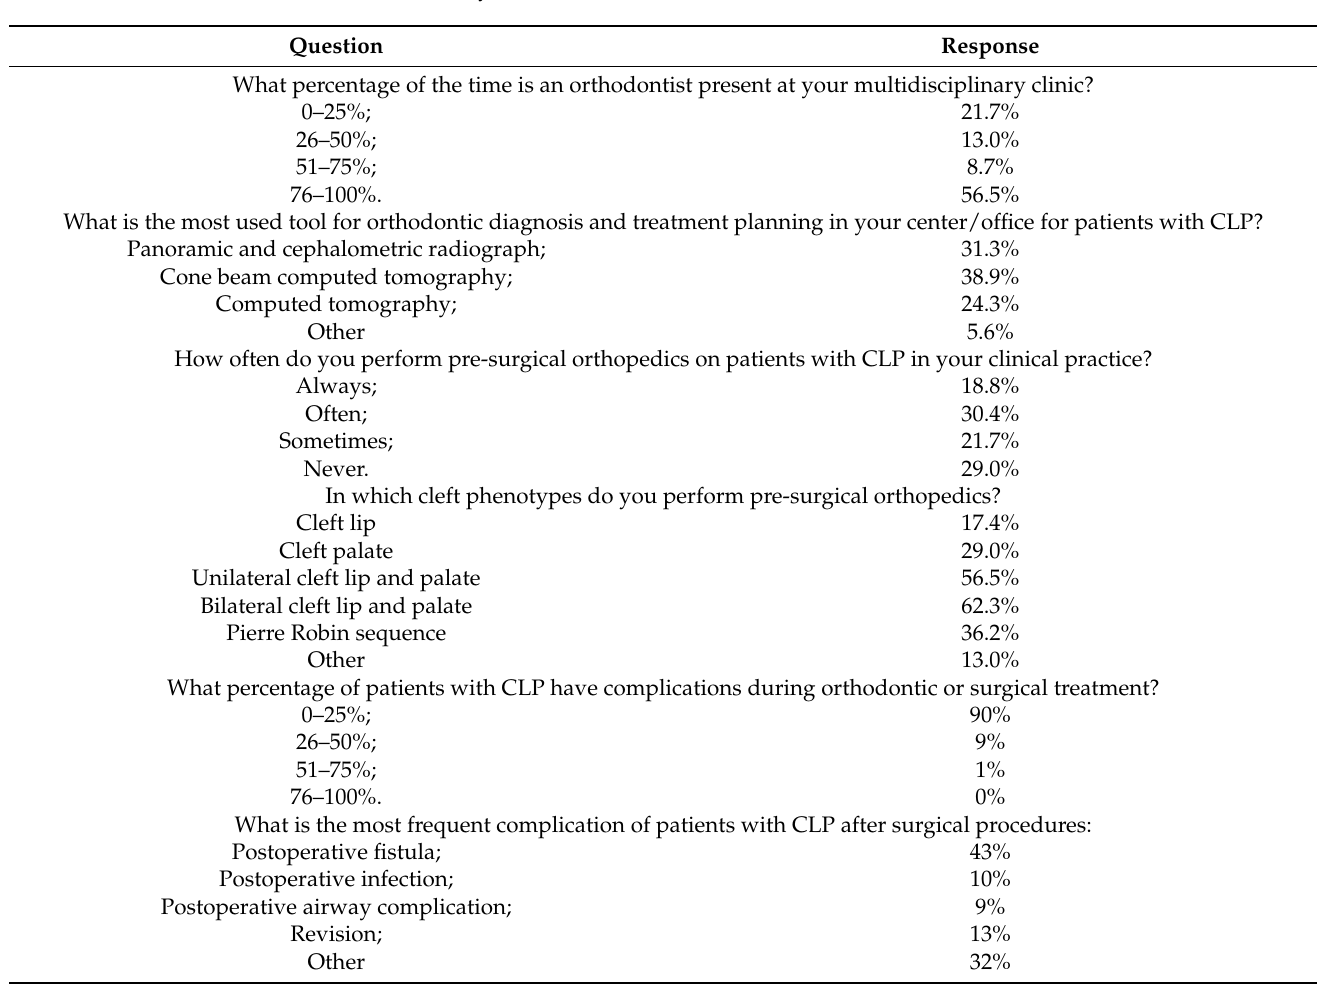
Table 3. Survey results on orthodontic